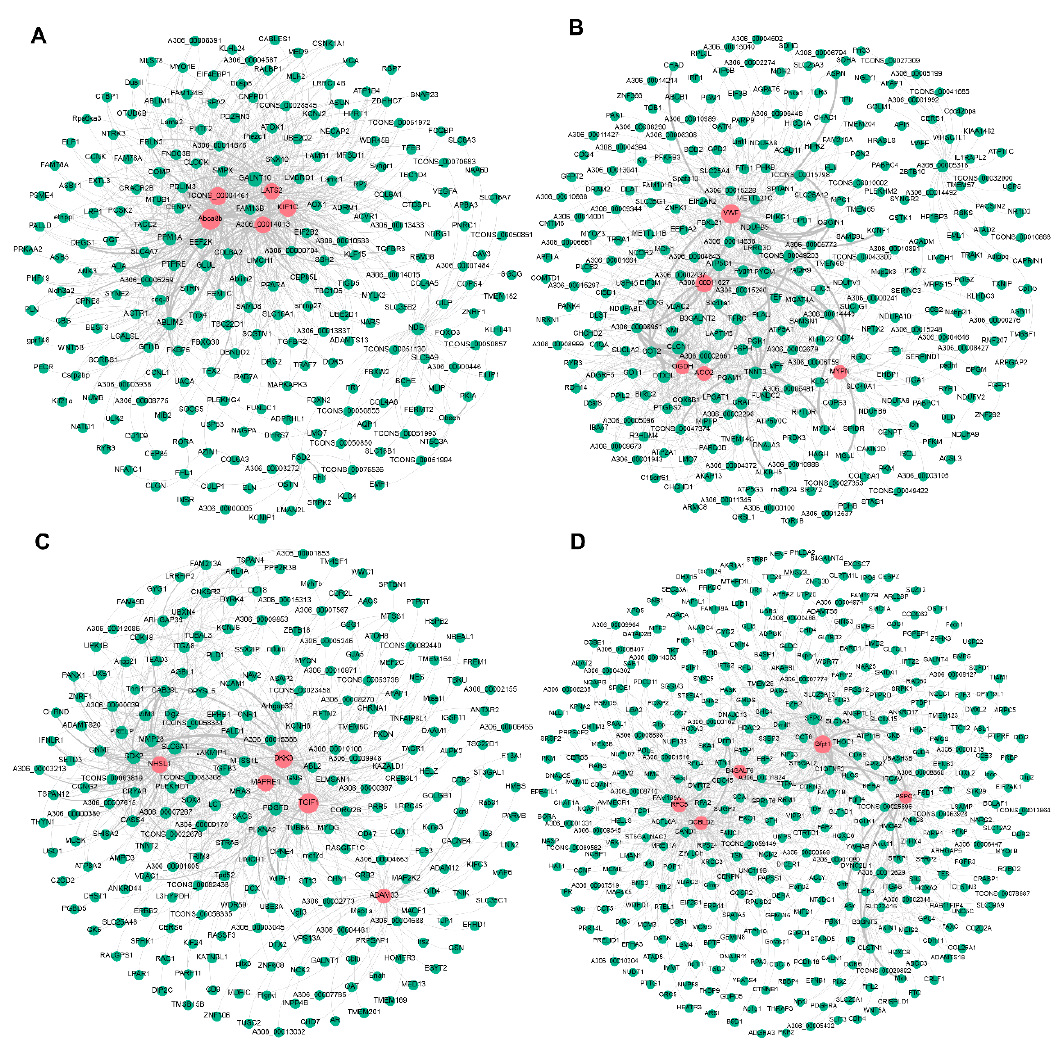
Figure 3. Visualisation of the four modules related to pigeon muscle development and growth. Networks ( A – D ) represent visualisations of gene interactions of black, brown, cyan and turquoise modules, respectively. The node size indicates the node degree. The line thickness indicates the strength of the correlation. Red nodes represent hub DEGs in each module.